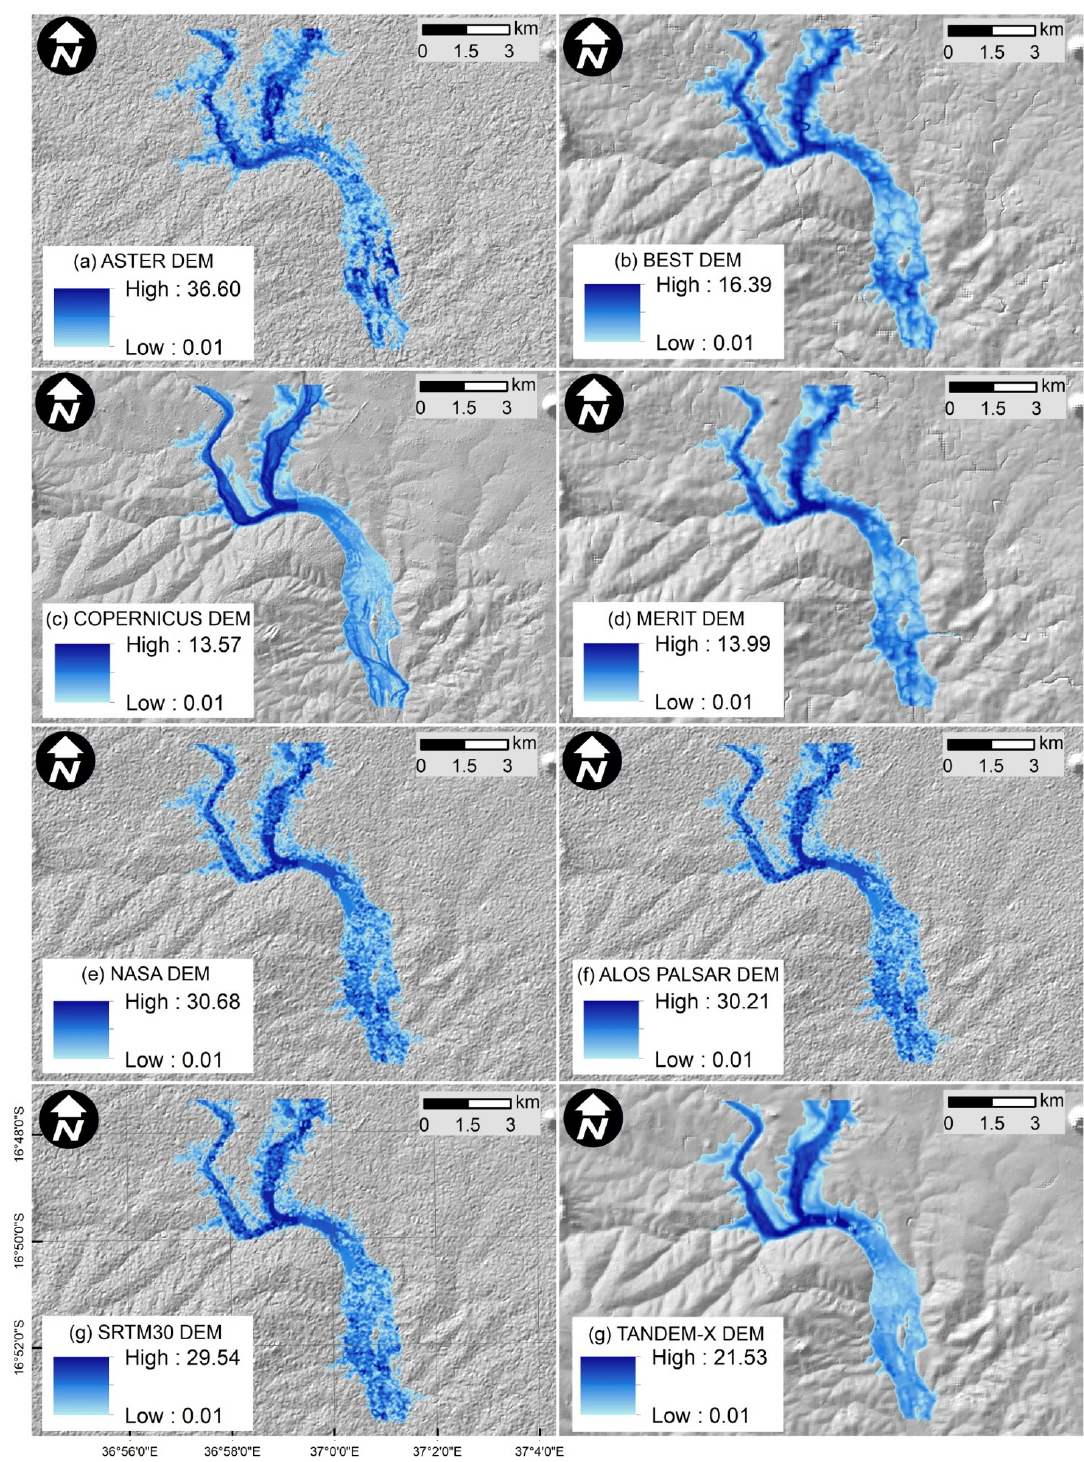
Figure 6. Flow depth results for the January 2015 flooding event in each one of the free global DEMs used, where the peak flow data used (18,000 m 3 s − 1 ) comes from previous reports [52].